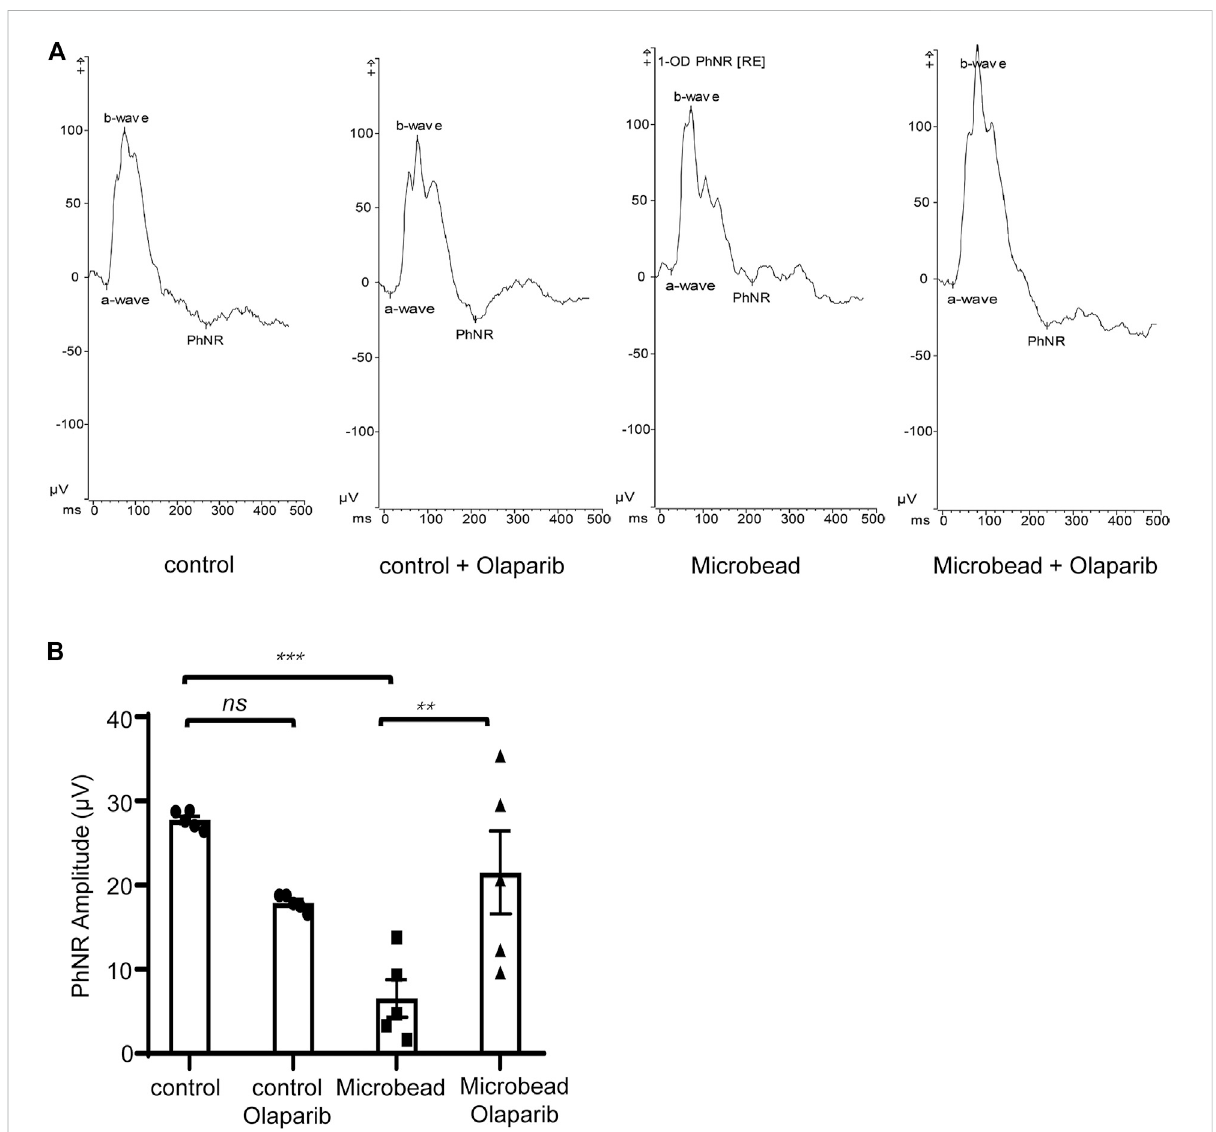
FIGURE 6 OlaparibenhancesthePhNRintheCOHrats. (A) Typicalphotopicnegativeresponses(PhNR)inthecontrol,control+olaparib,microbead,and microbead + olaparib group. (B) Statistical analysis of PhNR amplitudes in the aforementioned groups. Data are presented as the means ± SEM ( n = 5 rats per group). The p -values were determined using one-way ANOVA with Tukey ’ s test for multiple comparisons. pppp p <